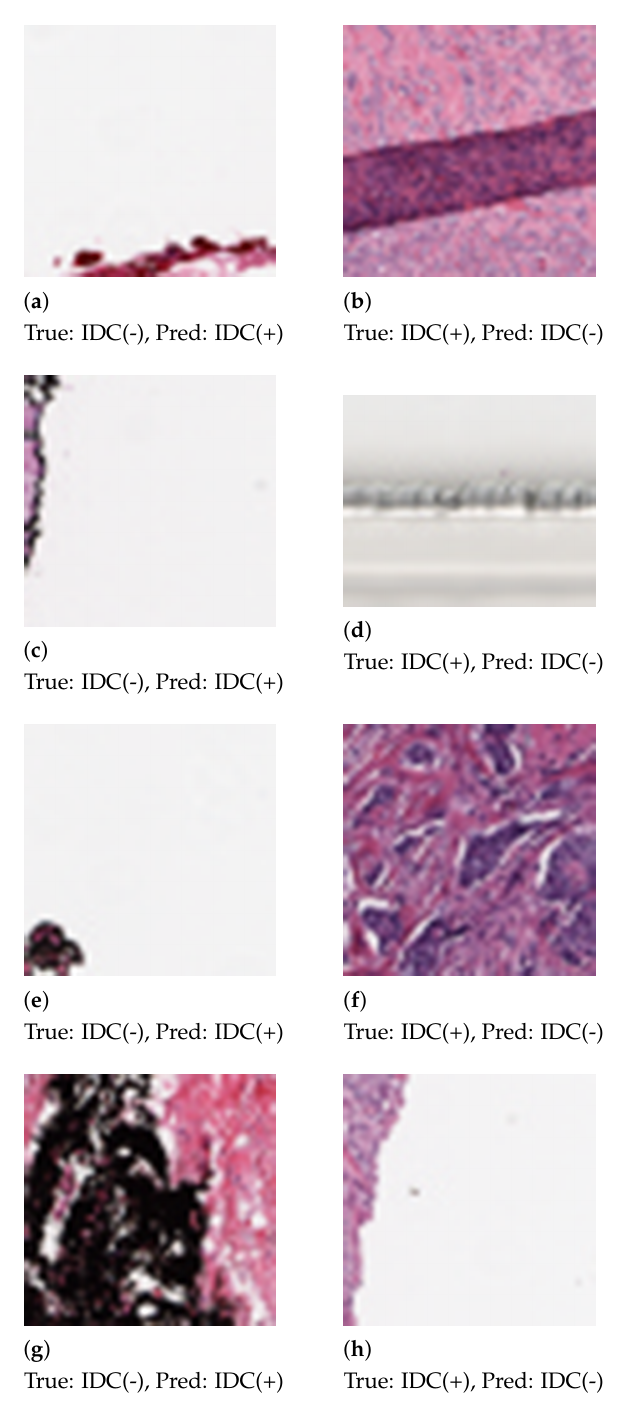
Figure 6. Patches that are misclassified by the proposed method. In the first column ( a , c , e , g ) are false positive errors. In the second column ( b , d , f , h ) are false negative